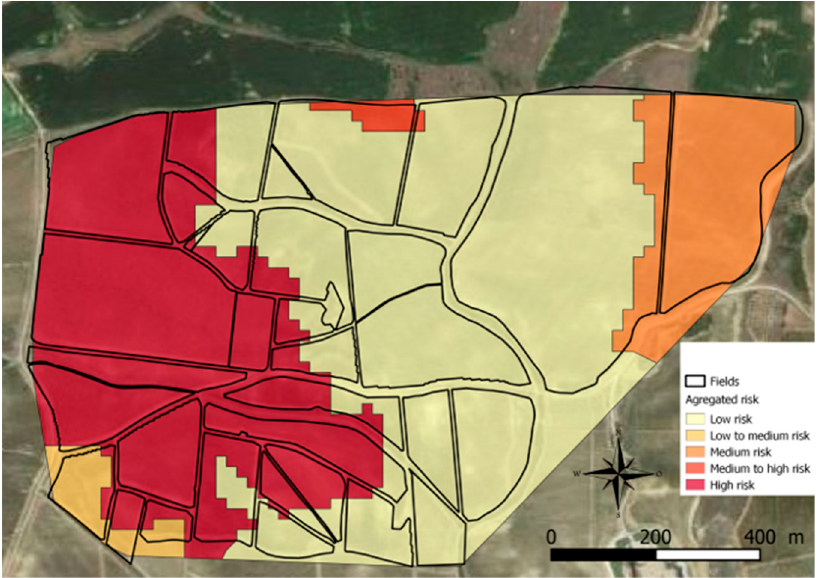
Figure 13. Aggregated risk zones of sub-optimal management practices derived using the NDVI, EC a , and elevation layers together with local expert knowledge. Agriculture 2018 , 8 , x FOR PEER REVIEW